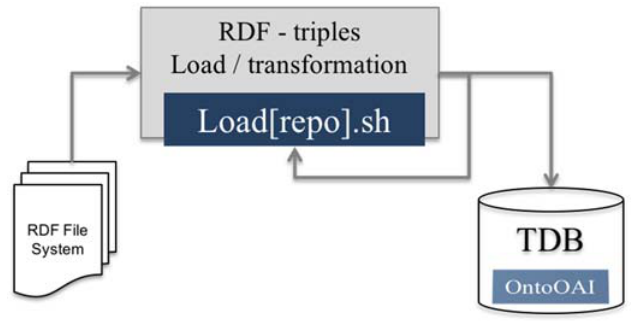
Figure 7. Triple storage process.